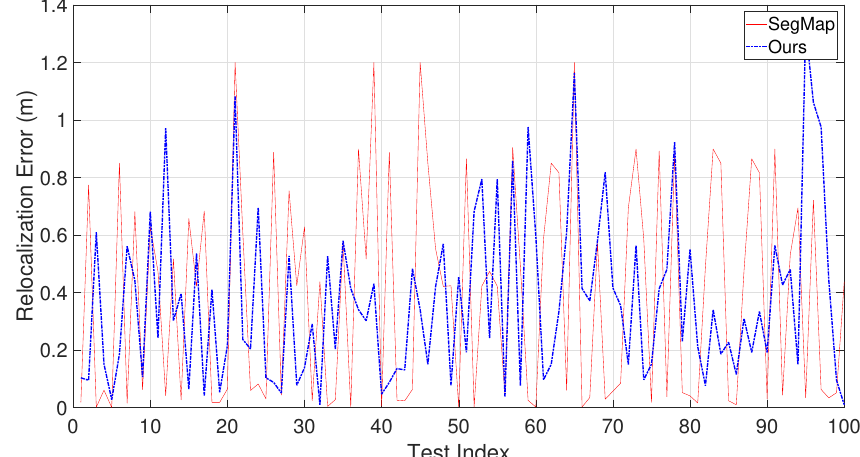
Figure 16. Comparison on the relocalization error on KITTI sequence 00 between SegMap and